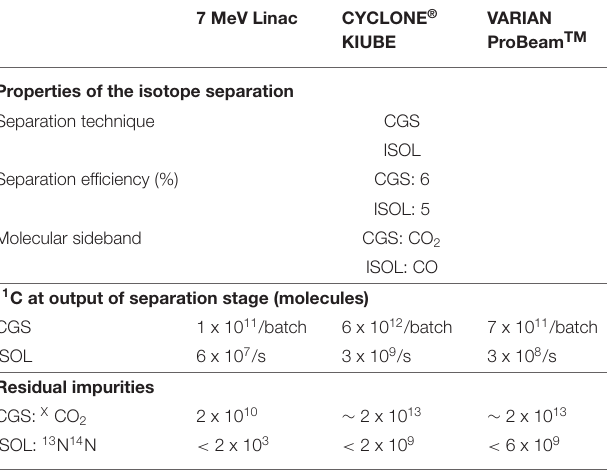
TABLE 5 | Expected 11 C available after the separation stage for a BN target, together with the corresponding impurities.